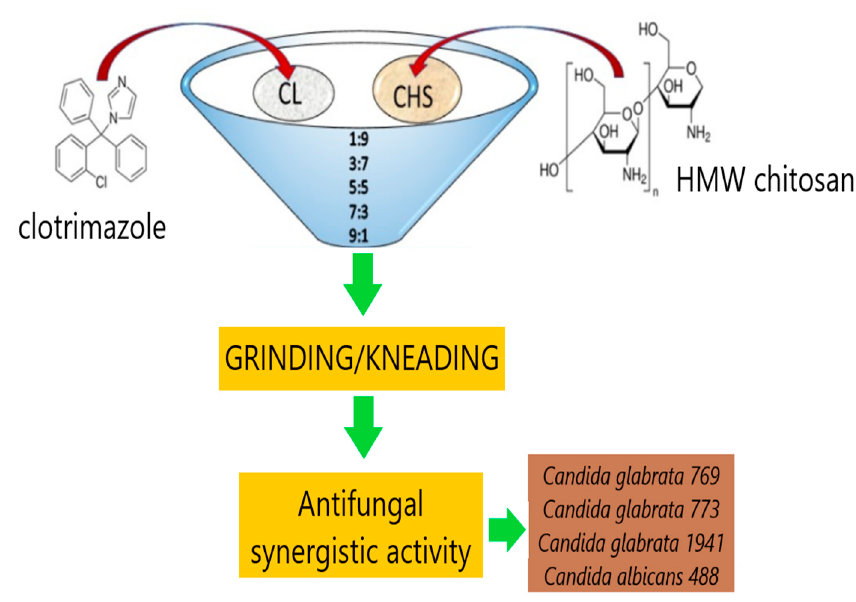
Figure 4. The procedure of preparation and synergistic antifungal effect of high molecular weight chitosan—clotrimazole mixture. Adapted from [58], Marine Drugs 2020.